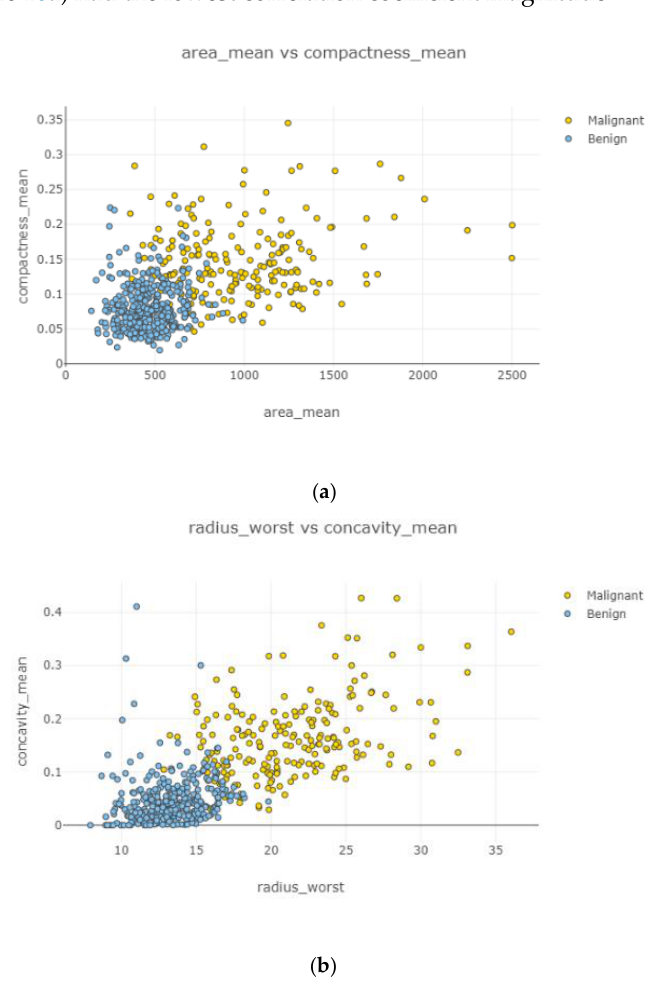
Figure 10. Positively correlated scatter plots 5–6.